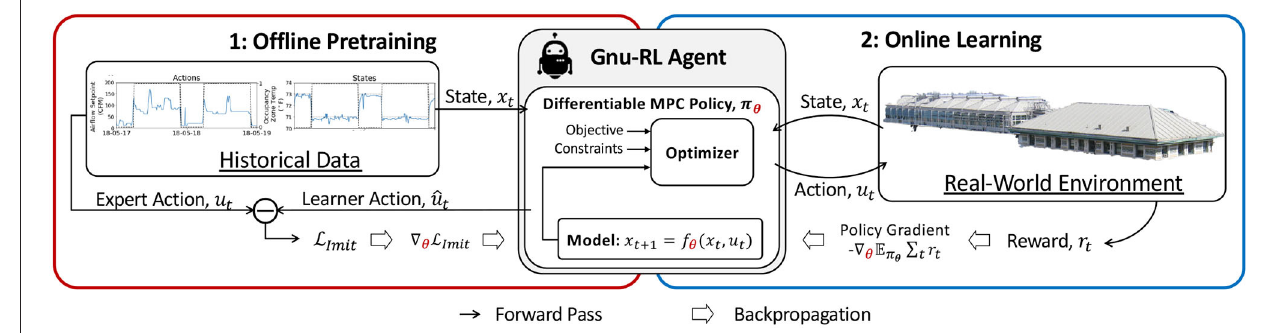
FIGURE 1 | Framework. The Gnu-RL agent utilizes a Differentiable MPC policy, which encodes domain knowledge on planning and system dynamics. In the offline pretraining phase, the agent is initialized by imitating historical data from the existing controller. In the online learning phase, the agent continues to improve its policy end-to-end using a policy gradient